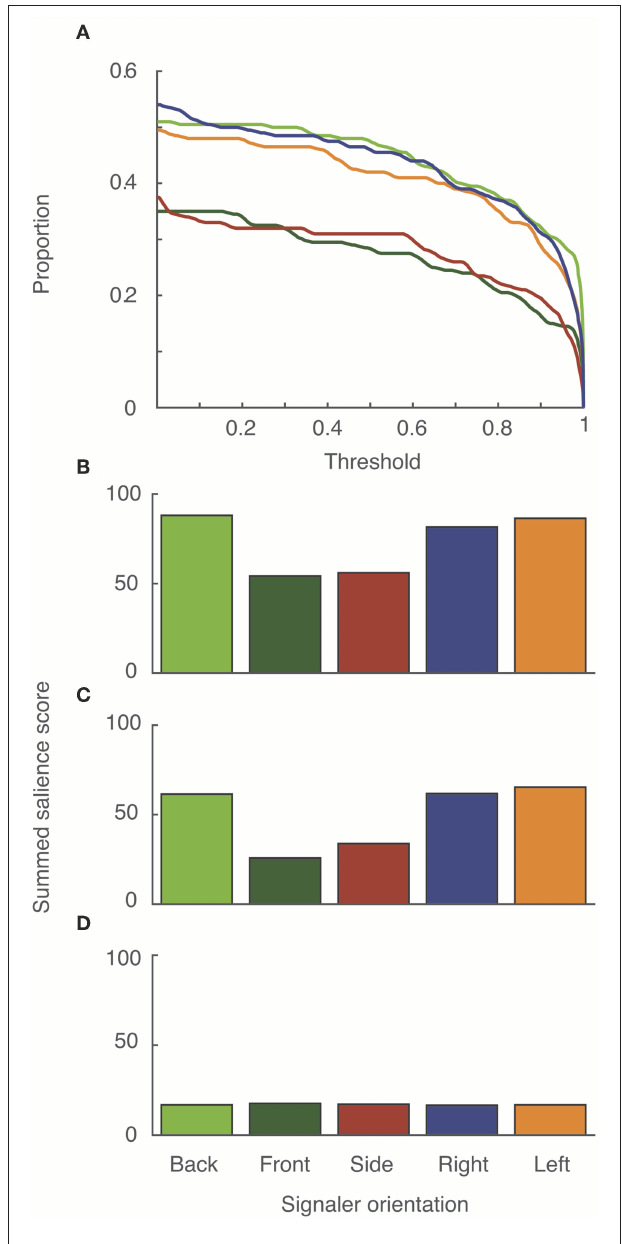
FIGURE 10 | Signal effectiveness was mediated by signaler orientation, but only for tail-flicking. (A) The proportion of lizard displays with salience scores exceeding receiver thresholds for response, shown separately for five different signaler orientations. Summed salience scores for the whole display (B) , and for the tail flick component (C) and rest of the display (D) separately. The color scheme in (A) is the same as in (B,D)